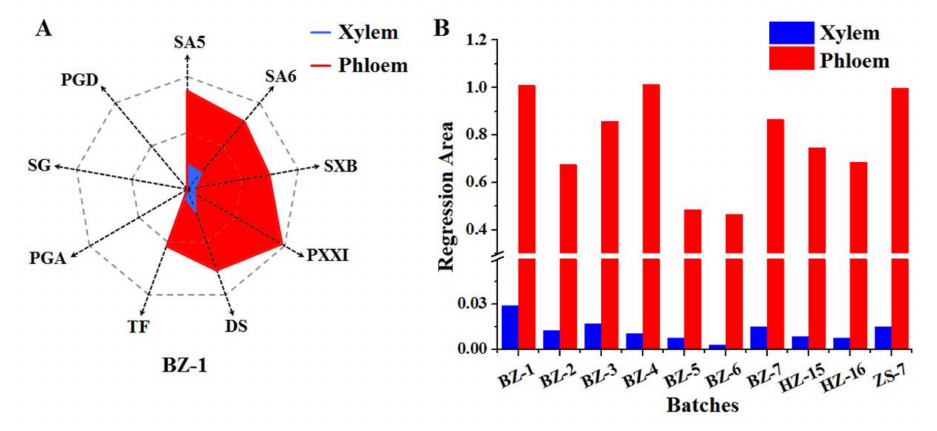
Figure 2. The representative “spider-web” mode of RP’s xylem and phloem established by taking the standardized content of nine compounds into account ( A ) and the histogram of shade area calculated from “Spider-web” mode of xylem and phloem from the different batches, respectively ( B ).